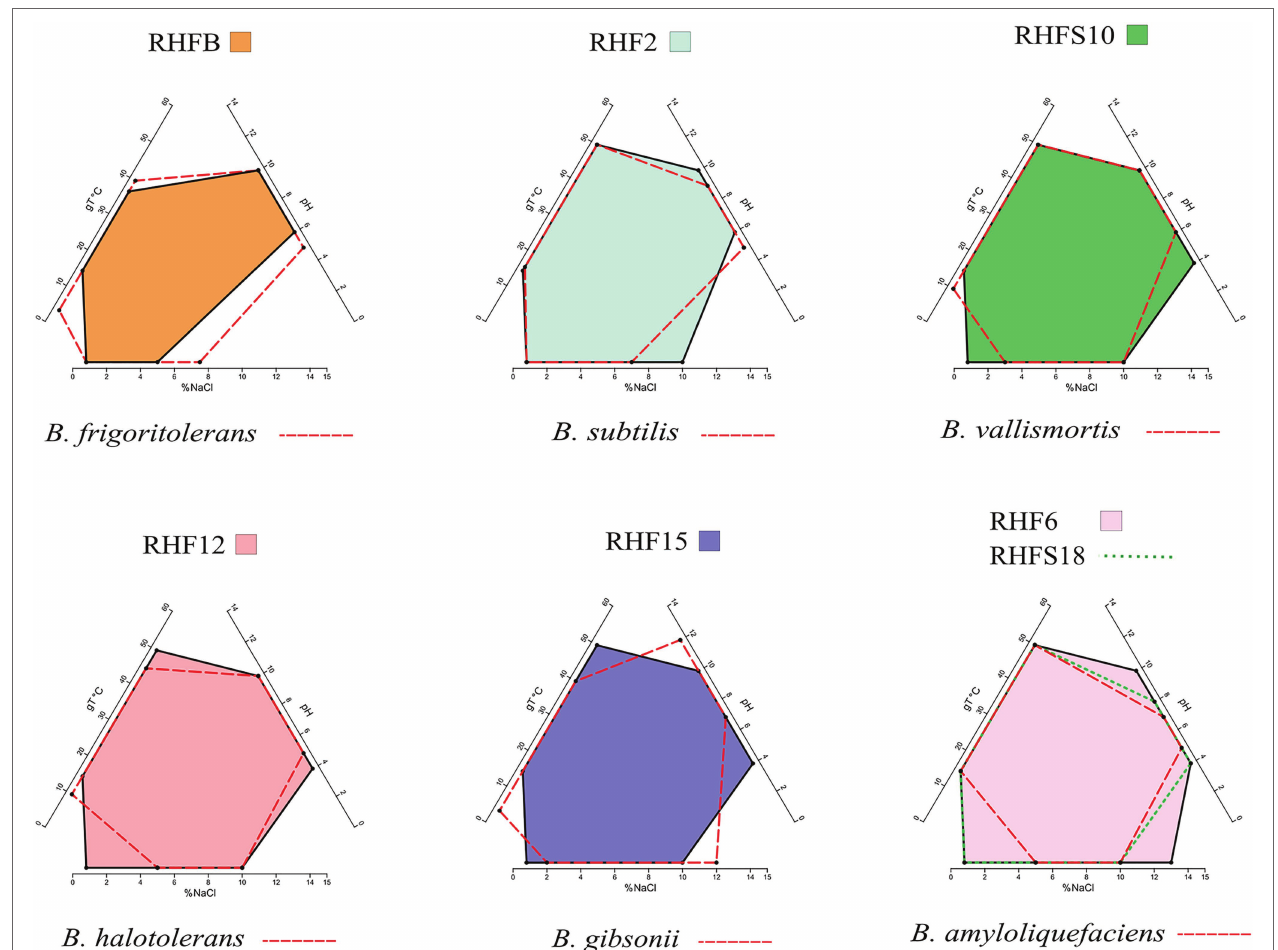
FIGURE 2 | Phenotypic plasticity of the salt-pan isolates. Multivariate polygons plots (Giovannelli et al., 2021, in preparation) showing the growth temperature (gT ° C), pH, and salinity (% NaCl) boundaries observed for the seven isolates (polygons) and the range for the closest relative identified by ANI (red dashed lines). Each edge represents the range for the specific variables projected onto the axis. More information about polygons plot can be found at https://giovannellilab.